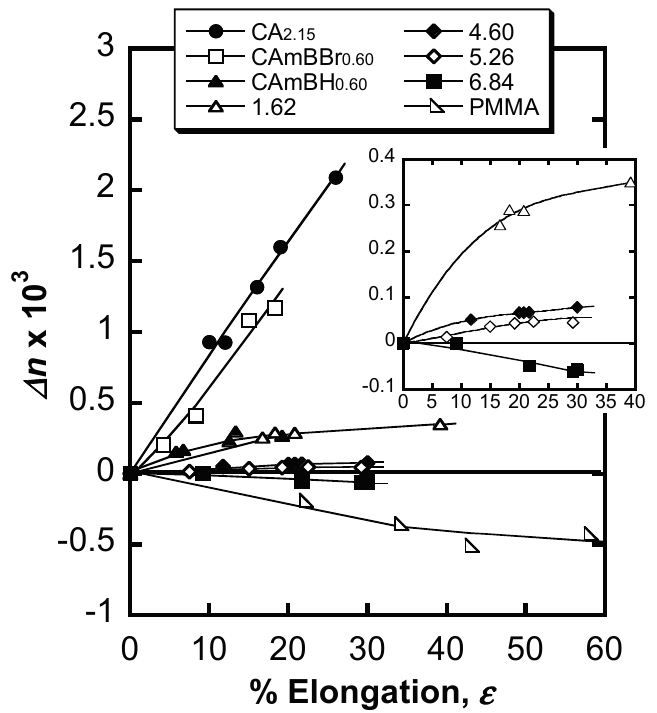
Figure 32. Birefringence plots of films comprising CA- g -PMMA copolymers and their component polymers and related ones as a function of elongation. Numerals represent MS values for the CA- g -PMMA series. Inset: graft copolymer data on an enlarged scale. Reproduced with permission from ref. [73]. Copyright 2013 American Chemical Society.